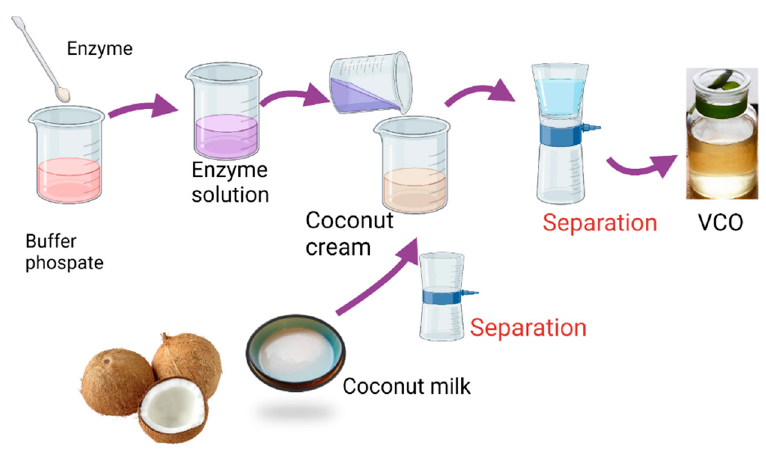
Figure 1. Preparation procedure of virgin coconut oil using papain.